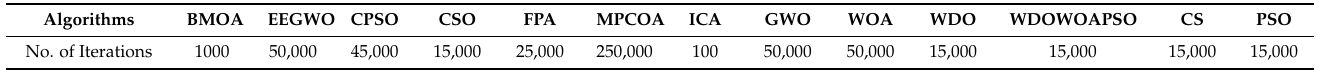
Table 20. Computing time-based analysis with two computers with distinct features. Table 21. Number of the iteration for the